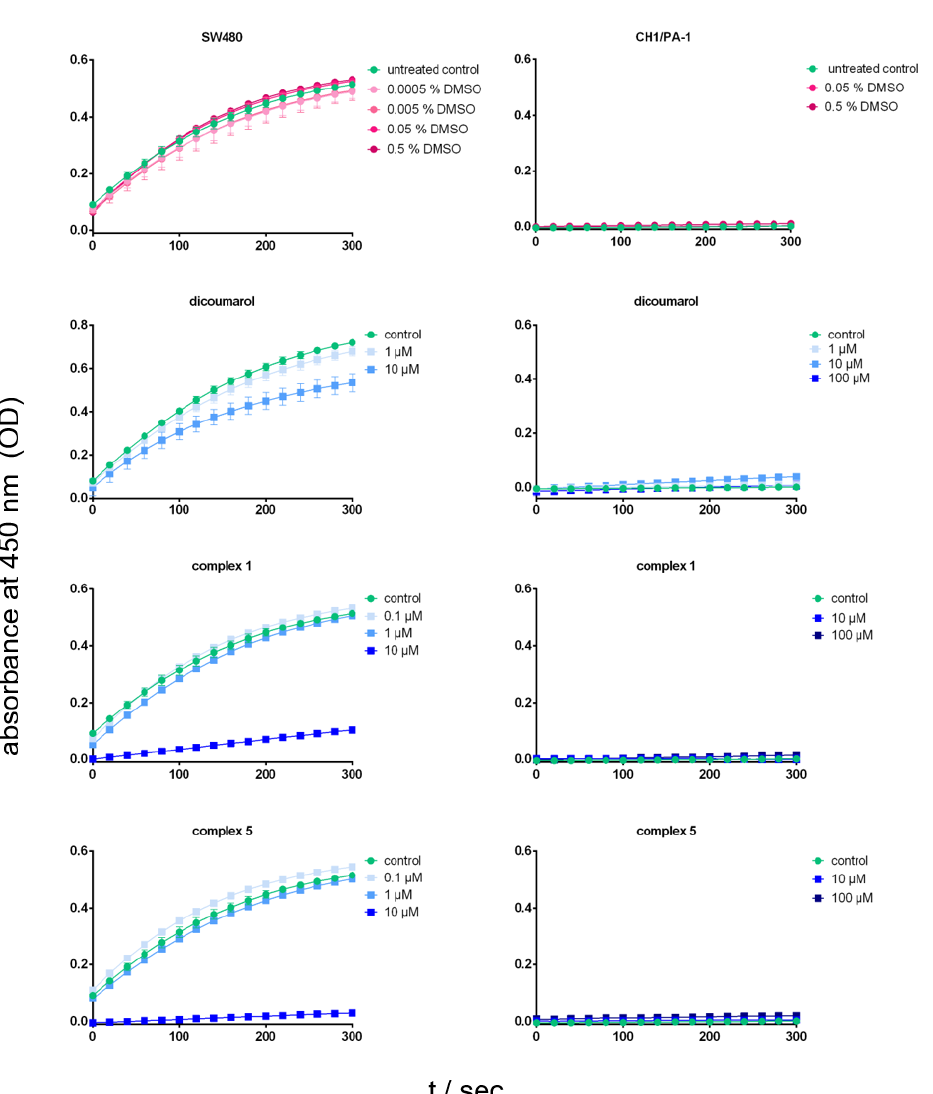
Figure 10. Time-dependent impact on NQO1 activity in SW480 (left panel) and CH1/PA-1 (right panel) cell extracts after treatment with the most active complexes, 1 and 5, or dicoumarol (positive control) compared to negative controls with and without DMSO (concentrations corresponding to the content in solutions of the test compounds). Data are expressed as OD (450 nm) per 100 µg/mL of total cellular protein.